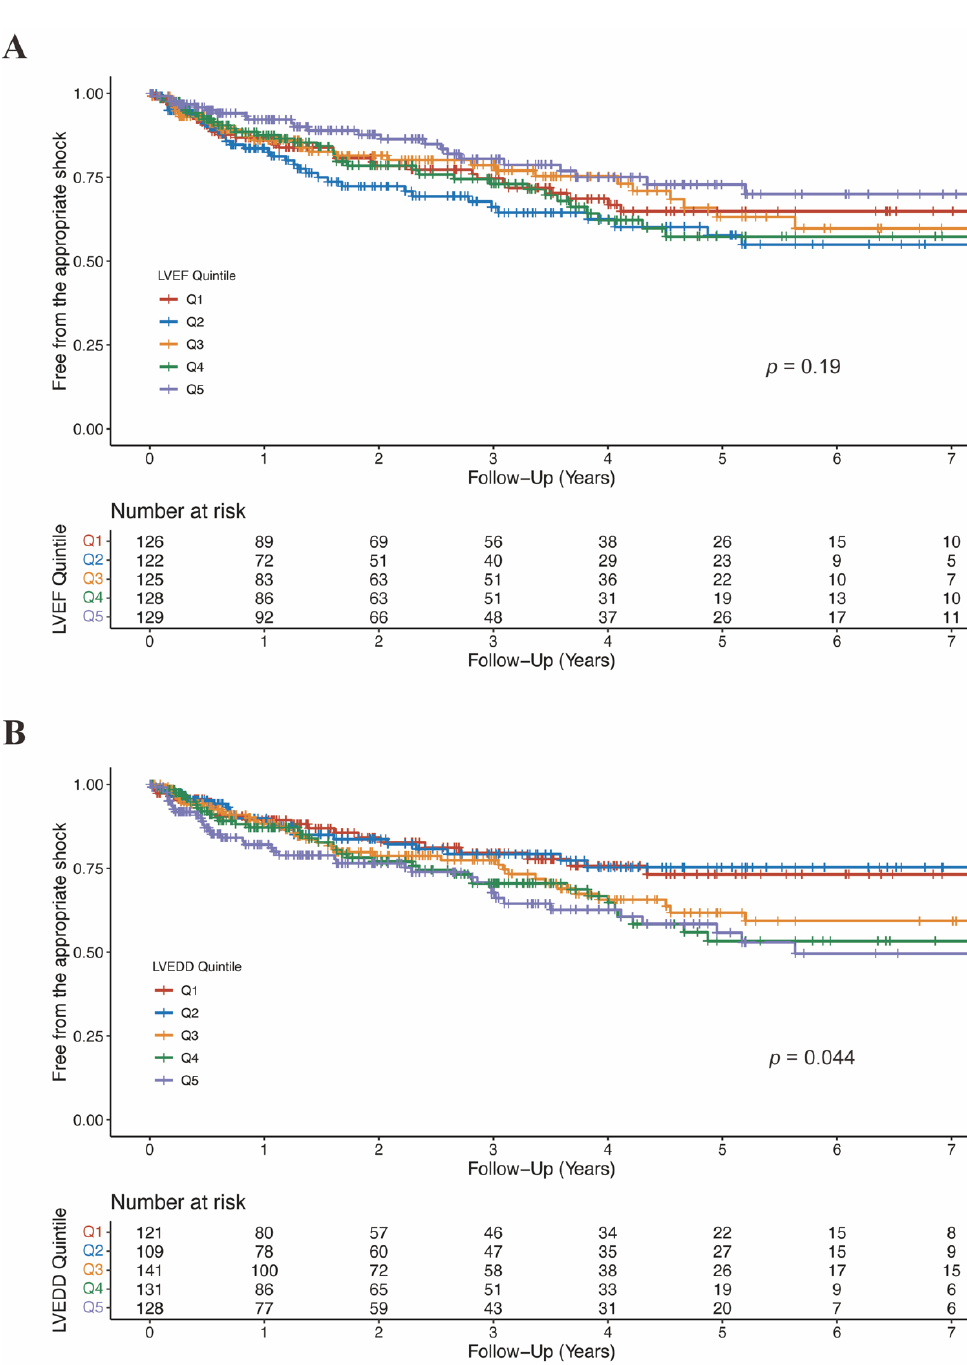
Figure 5. Free from the appropriate shock by LVEF quintiles ( A ) and LVEDD quintiles ( B ). CI, con- fidence interval; LVEDD, left ventricular end-diastolic diameter; LVEF, left ventricular ejection frac- tion.